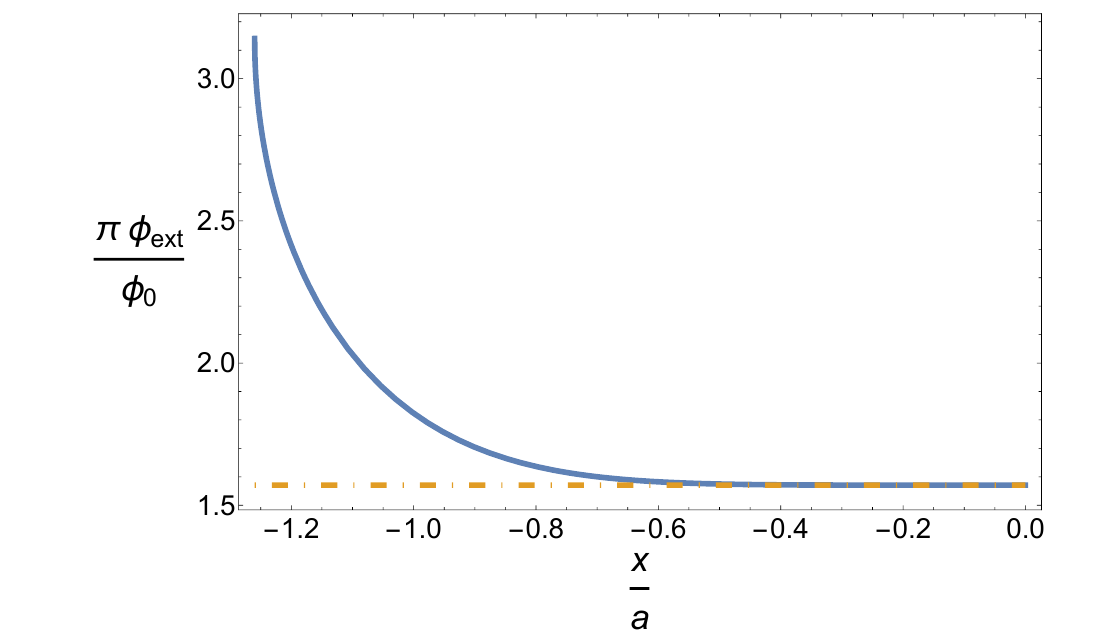
Figure 1. External magnetic flux πφ ext / φ 0 versus the adimensional distance x / a . The dashed line represents the threshold value πφ ext / φ 0 = π